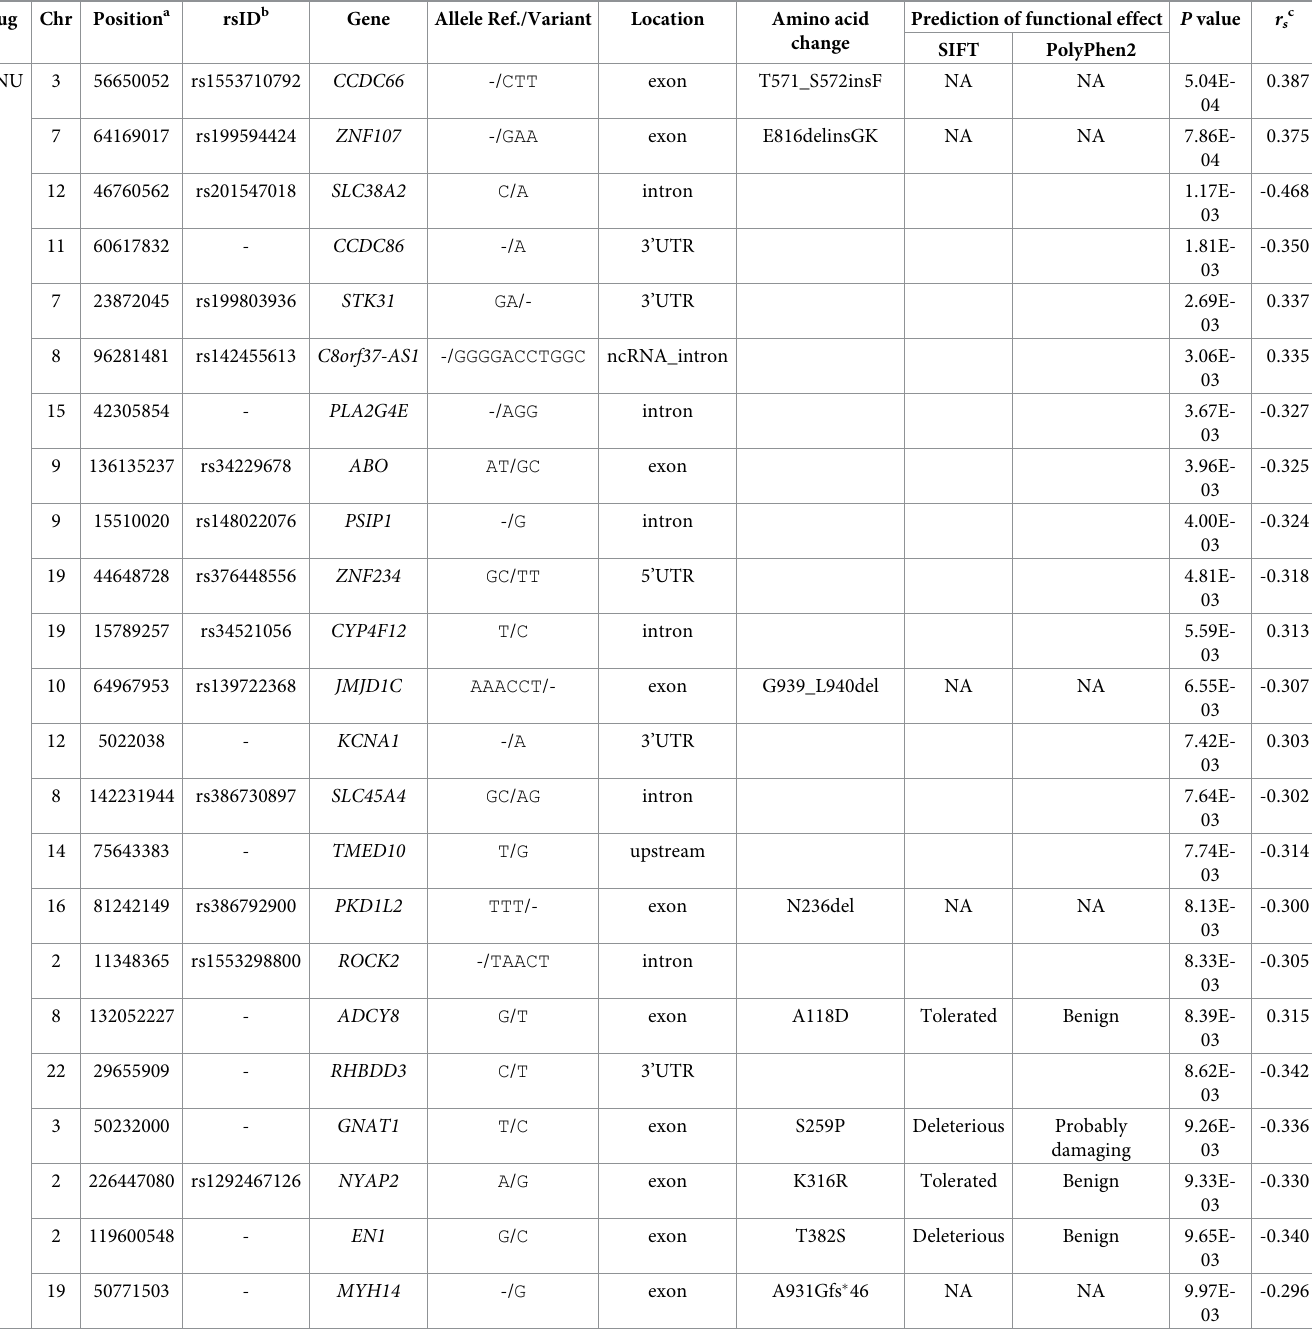
Table 2. Variants associated with chemosensitivity to ACNU (P < 0.01), as identified among 79 xenografts. Drug Chr Position